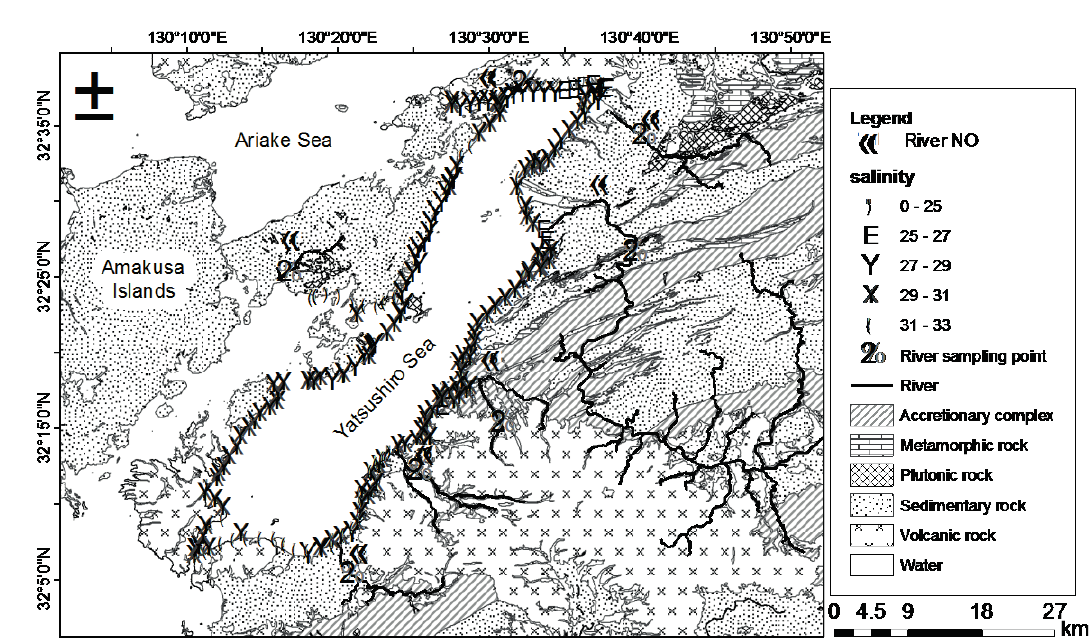
Fig. 3 The distribution map of sea water salinity in the study area.